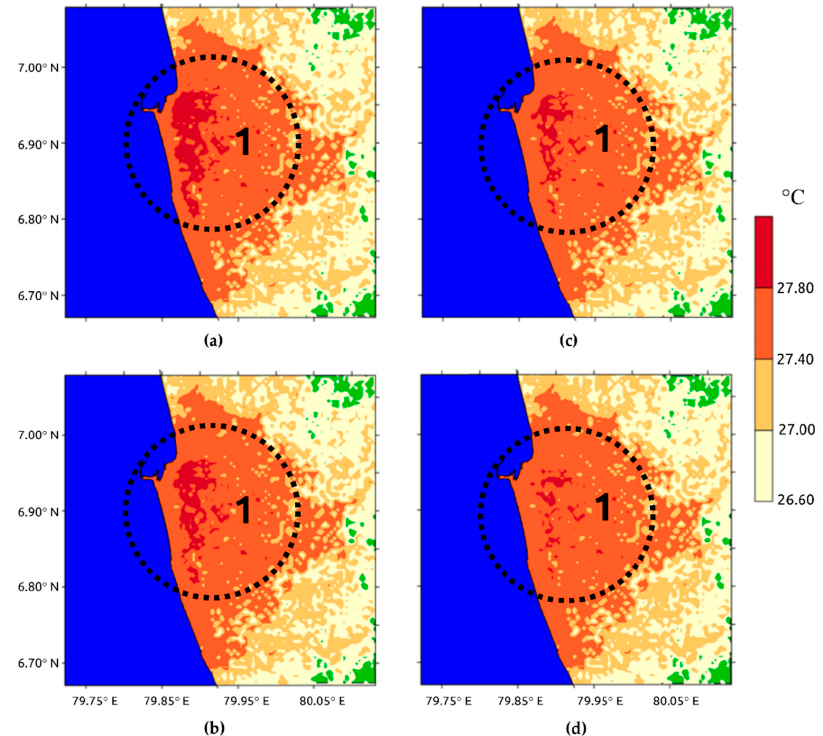
Figure 7. (a) Average temperature distribution due to land-use change in 2015; (b) Average Figure 7. ( a ) Average temperature distribution due to land-use change in 2015; ( b ) Average temperature temperature distribution with 10% greening; (c) 20% greening; (d) 30% greening. distribution with 10% greening; ( c ) 20% greening; ( d ) 30% It shows that the extent of the UHI effects can be reduced by 17.62 km 2 (26%), 31.25 km 2 (47%) and 43.31 km 2 (64%) when simulating scenarios 1, 2, and 3, respectively. The summary of model’s outputs from scenario 1, 2, and 3 are provided in Table 2 .